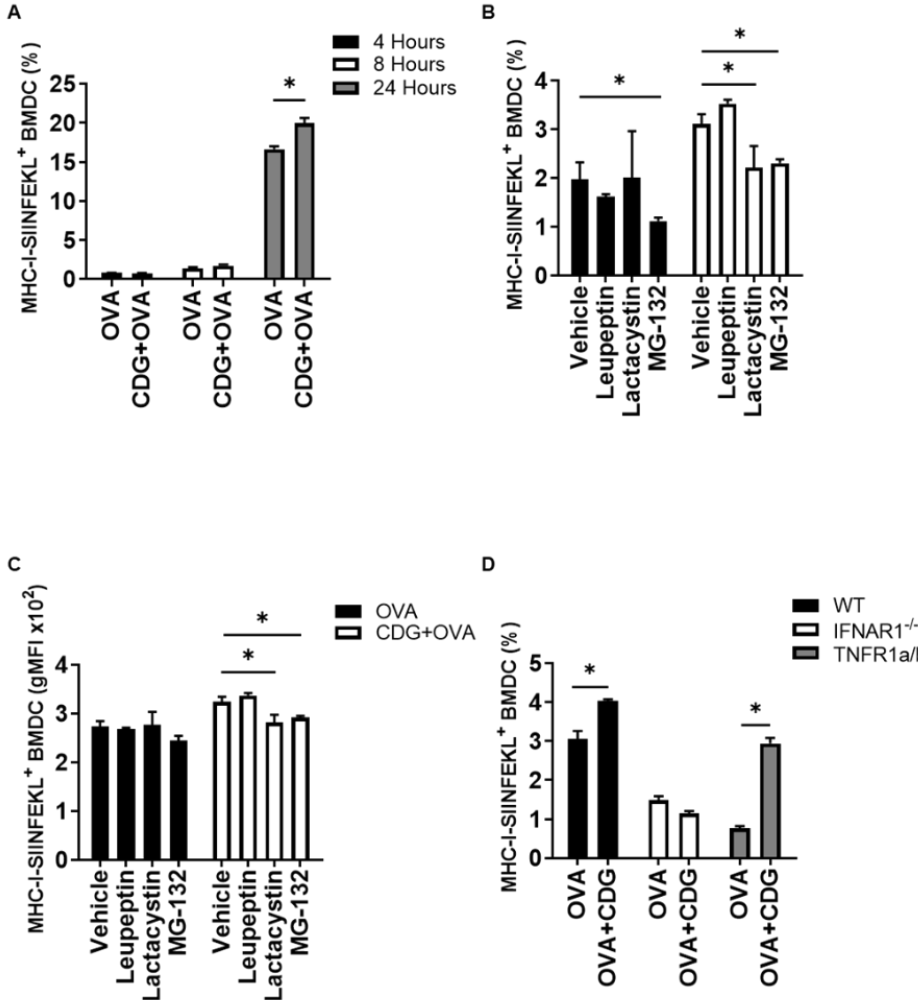
Figure 1. Cross-presentation of the OVA immunodominant peptide SIINFEKL in BMDC pulsed with OVA +/ − CDG. ( A ) WT BMDC were treated with OVA +/ − CDG for 4, 8 and 24 h. The frequency of cross-presenting BMDC was quantified using flow cytometry. ( B ) Frequency or ( C ) geometric mean of the fluorescence intensity (gMFI) of cross-presenting BMDC were quantified in the presence or absence of inhibitors of the cytosolic pathway (MG-132 or lactacystin) and an inhibitor of the vacuolar pathway (leupeptin). ( D ) Cross-presentation of BMDC from IFNAR1 − / − and TNFR1a/b − / − mice was compared to WT counterparts in the presence or absence of CDG. Error bars indicate SEM. Statistical significance was calculated using a one-tailed Student’s t -test. * indicates p < 0.05. The results are representative of two to three independent experiments.